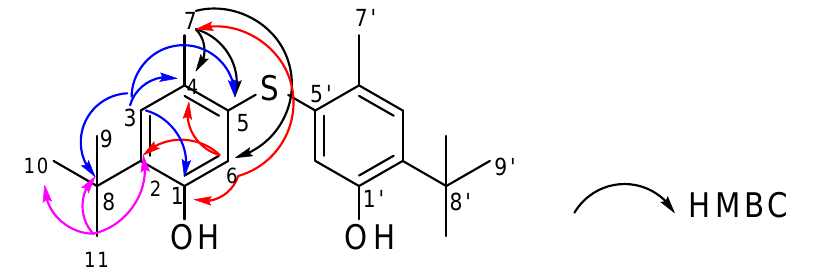
Figure 2. Key correlations for the structural assignment of 1 .